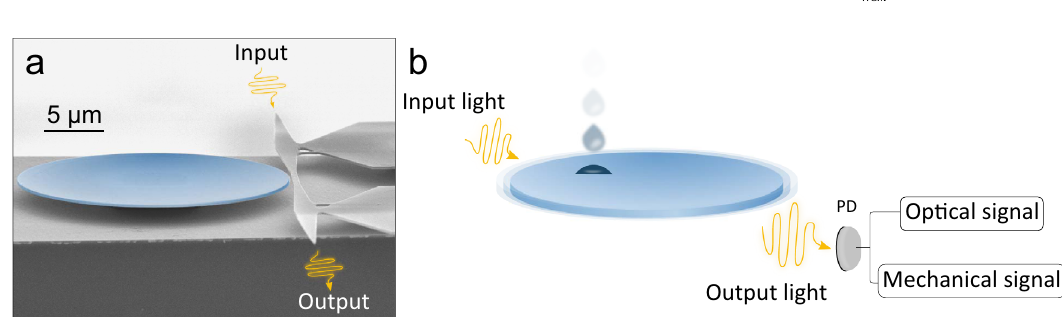
Fig. 1 | Optomechanical disk for nanodroplet measurement. a False-colored SEM image of the optomechanical resonator employed in these experiments. An integrated waveguide (right-hand side, light gray) is evanescently coupled to the disk (blue).It enables the injection (collection) of light into (from) it. b Illustration